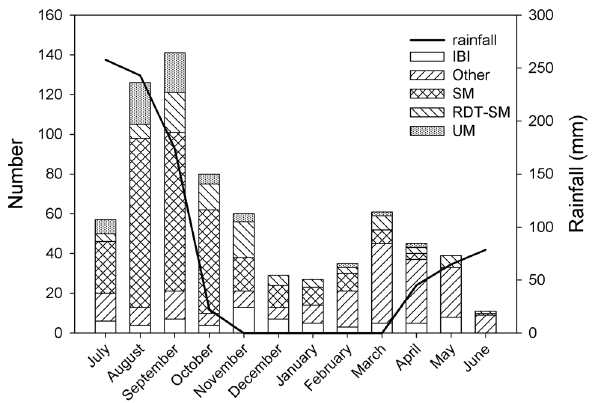
Figure 2. Distribution of severe malaria (SM) and invasive bacterial infection (IBI) by month. IBI = invasive bacterial infection, SM = severe malaria, RDT-SM = signs of severe malaria with negative microscopy and positive RDT, UM = uncomplicated malaria, Other = all other children included not fulfilling criteria of SM or IBI .